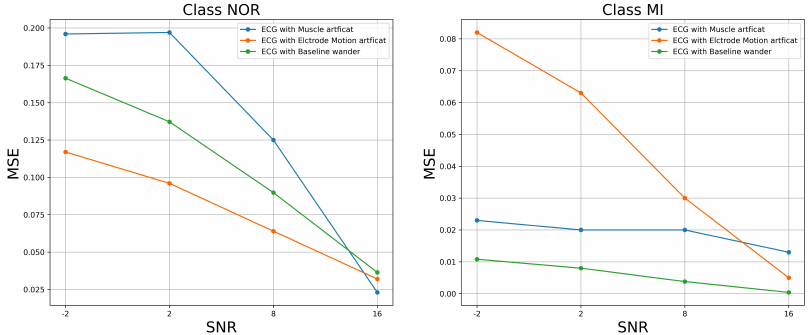
Figure 6. MSE versus SNR of the ECG-filtered signal with added